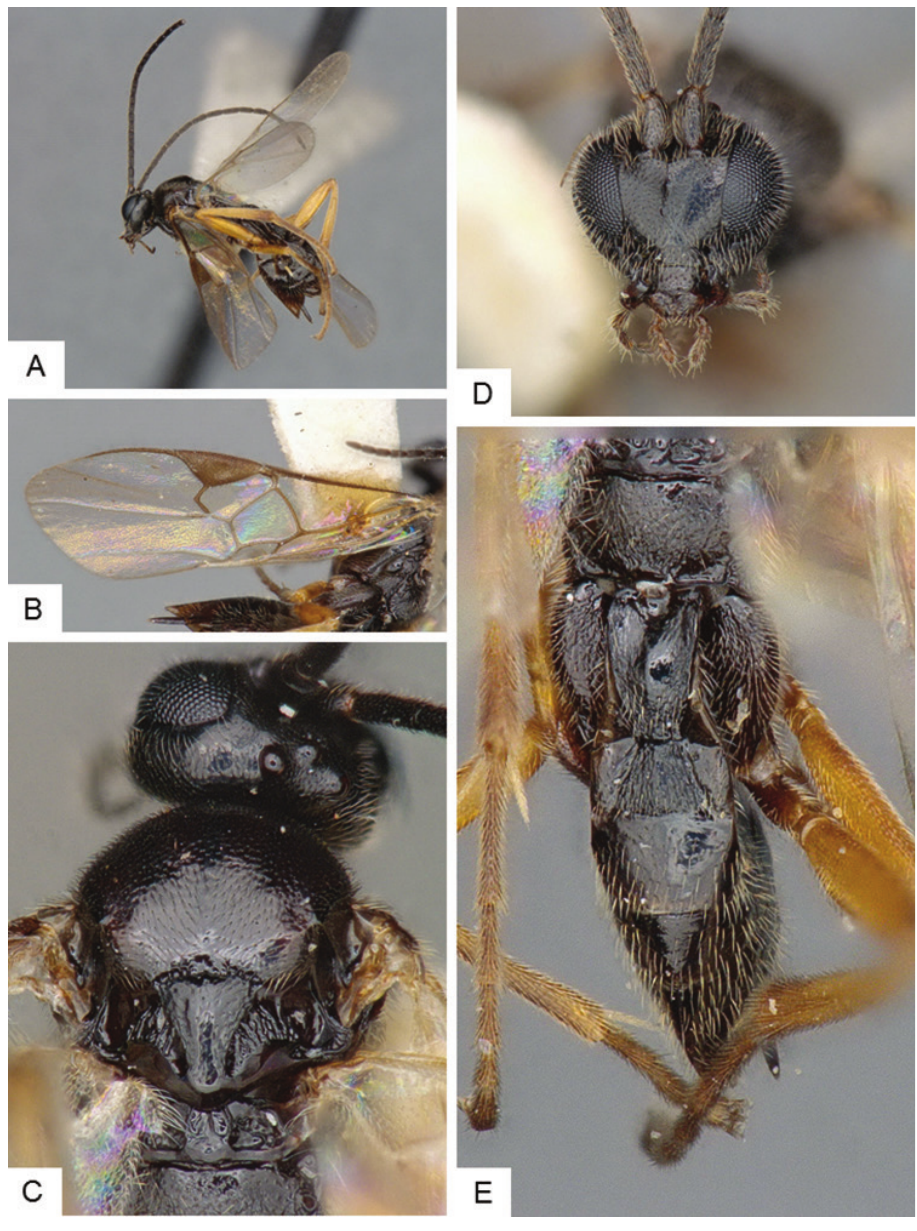
Figure 12. Glyptapanteles compressiventris . A Habitus, lateral B Fore wing C Head and mesosoma (par- tially), dorsal D Head, frontal E Metasoma,